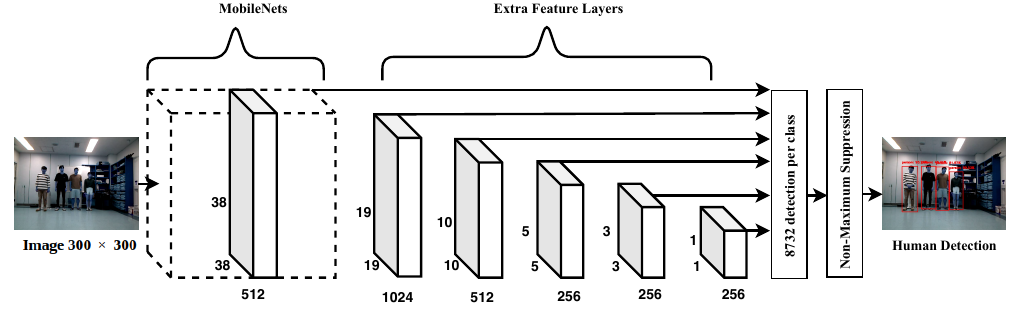
Figure 3. MobileNet-SSD network architecture.